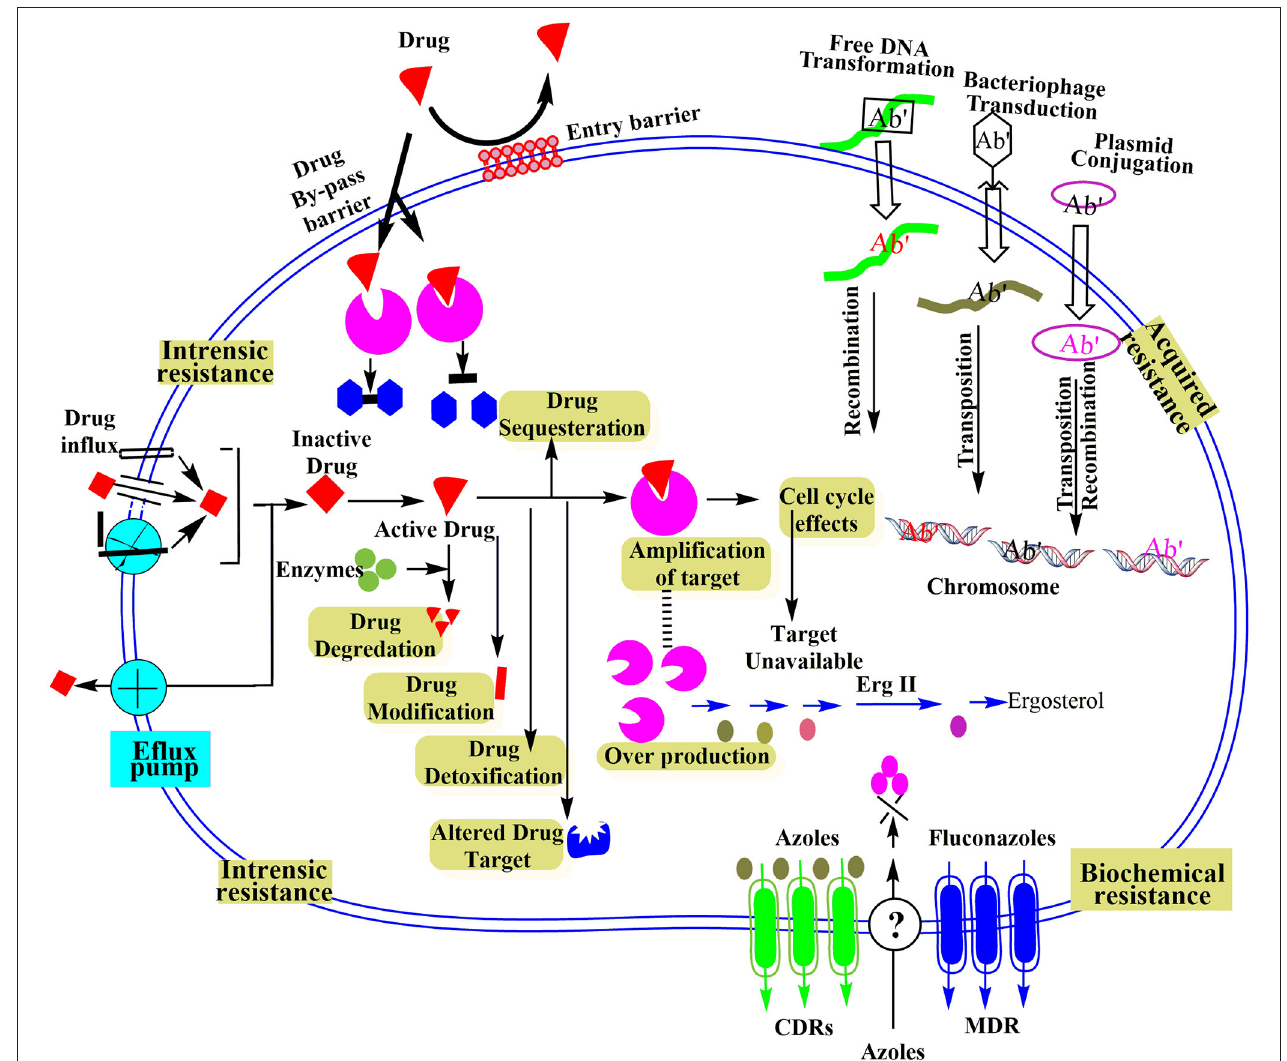
FIGURE 2 | Schematic illustration of different microbial resistance mechanisms at molecular level reproduced from Ray et al. (2017).